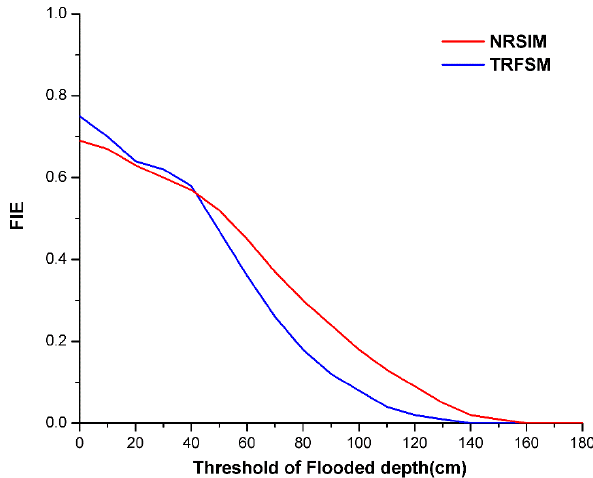
Figure 12. Relationship between thresholds of flooded depth and fit indicator of inundation extent (FIE) of TRFSM and NRSIM by using a 30 ‐ m resolution DEM.